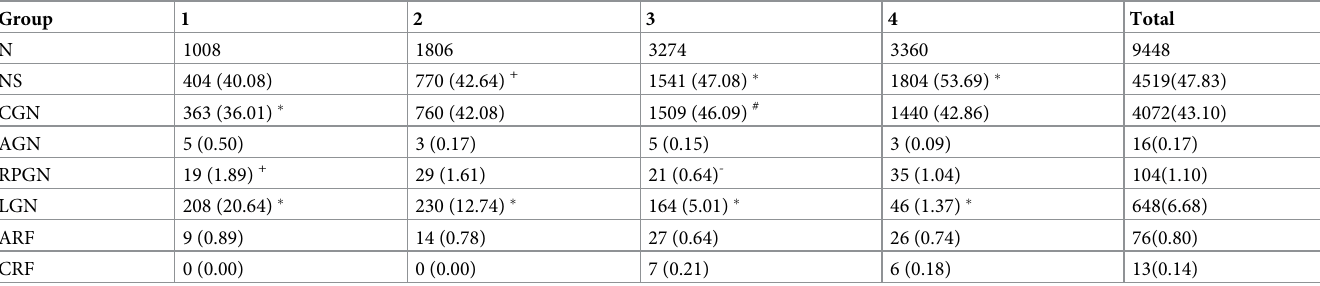
Table 3. Comparison of clinical manifestations in each